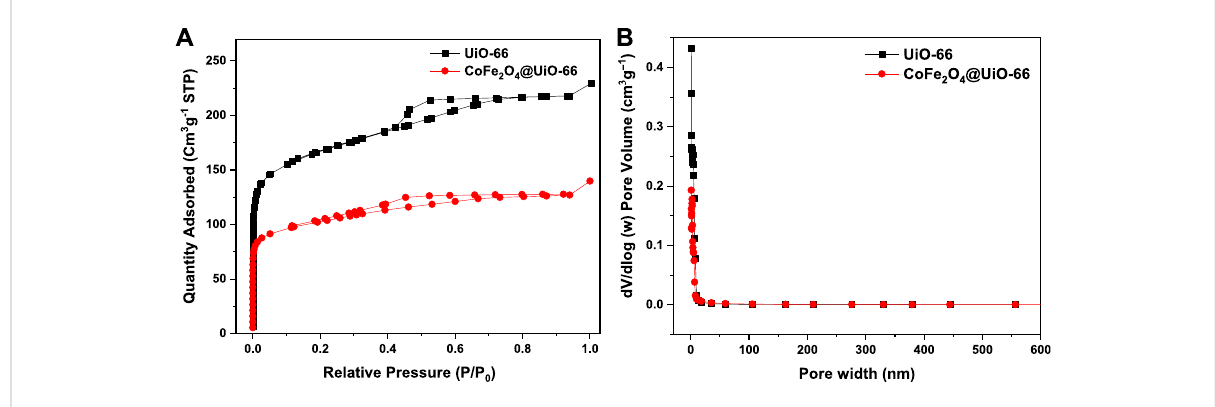
FIGURE 7 N 2 adsorption-desorption isotherms (A) , and pore size distribution curves (B) of UiO-66 and CoFe 2 O 4 @UiO-66 composite.